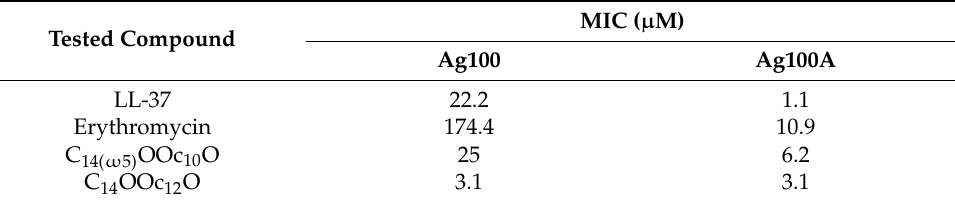
Table 3. Effect of RND pumps on MIC values of diverse